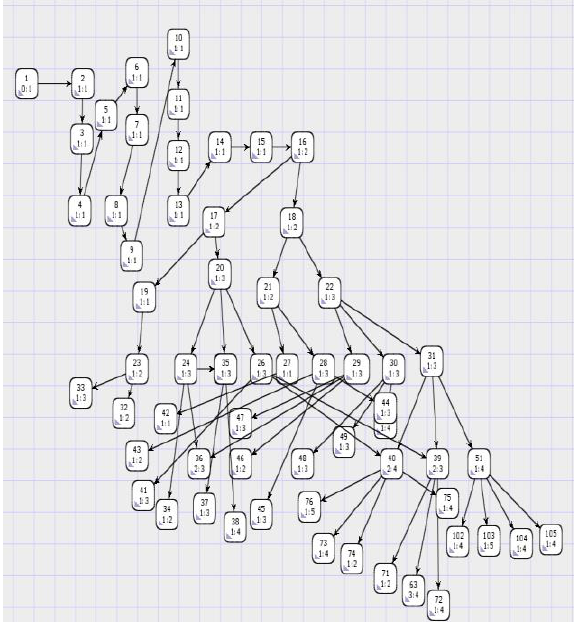
Figure 4. Reachability Graph of the HCI Interdependent